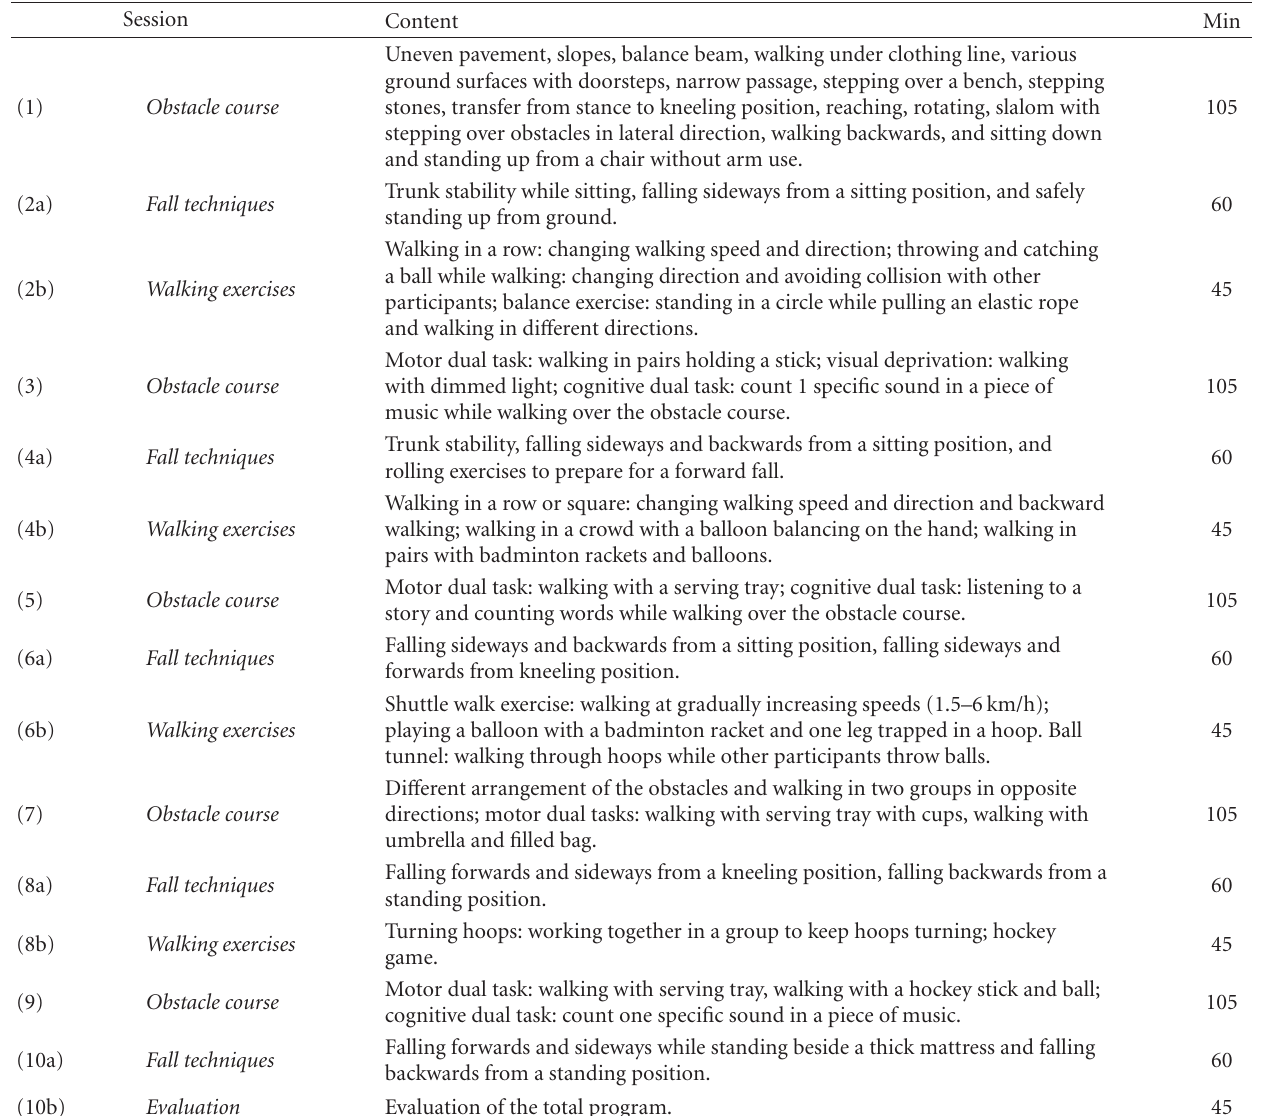
Table 1: Final content of the FALLS